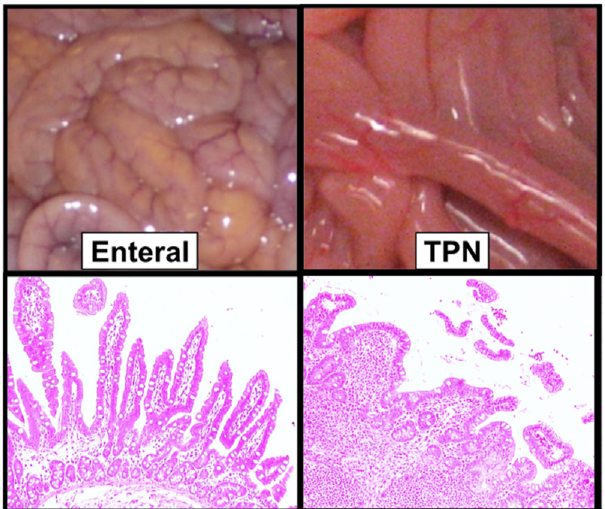
Figure 2. A Macroscopic Appearance and Stained Cross Section of Distal Small Intestine in Preterm Piglets Receiving Enteral Feeding vs. Total Parenteral Nutrition (TPN). Figure modified and re- produced with copyright permission from American Journal of Physiology-Gastrointestinal and Liver Physiology , Vol. 302, page 221, Copyright © 2012 by The American Physiological Society. Original ar- ticle published as “Enteral Bile Acid Treatment Improves Parenteral Nutrition-Related Liver Disease and Intestinal Mucosal Atrophy in Neonatal Pigs” by Jain et al.